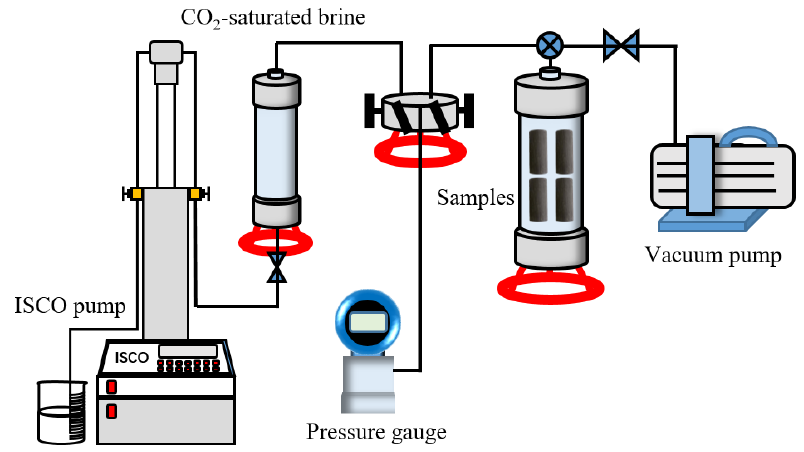
Figure 3. Schematic depiction of the experimental setup for CO 2